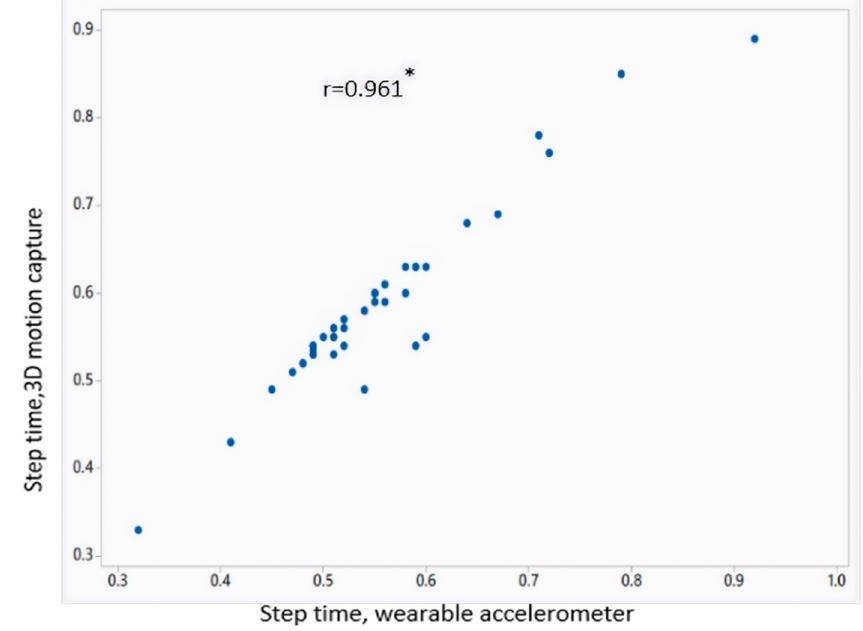
Figure 4. Mean error rate for gait parameters for left and right legs obtained from wearable accelerometer-based approach and 3D motion capture system.